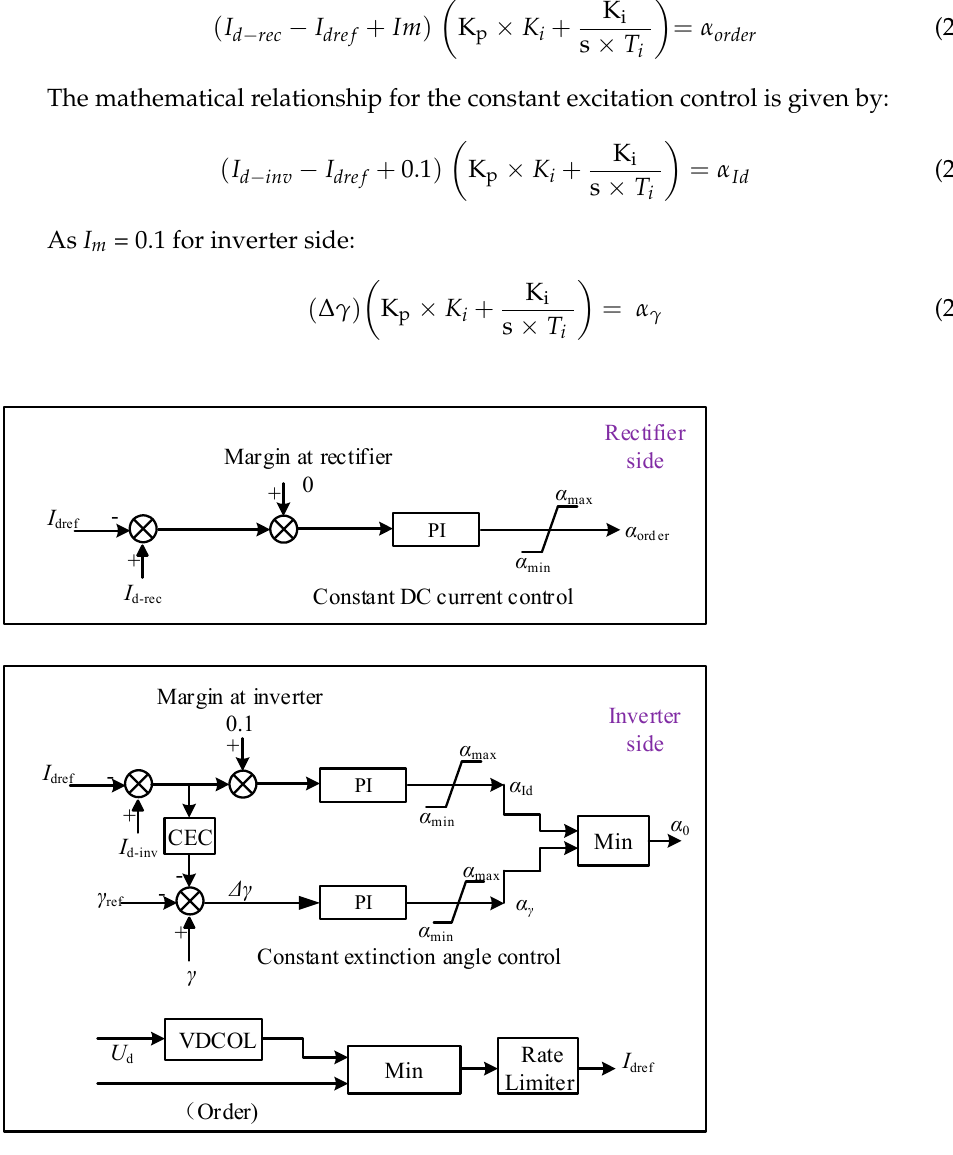
Figure 3. Control system of LCC-HVDC system.